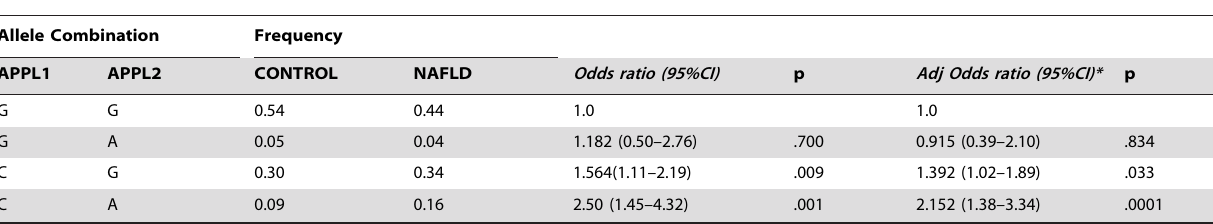
Table 3. Allele combination effect on NAFLD